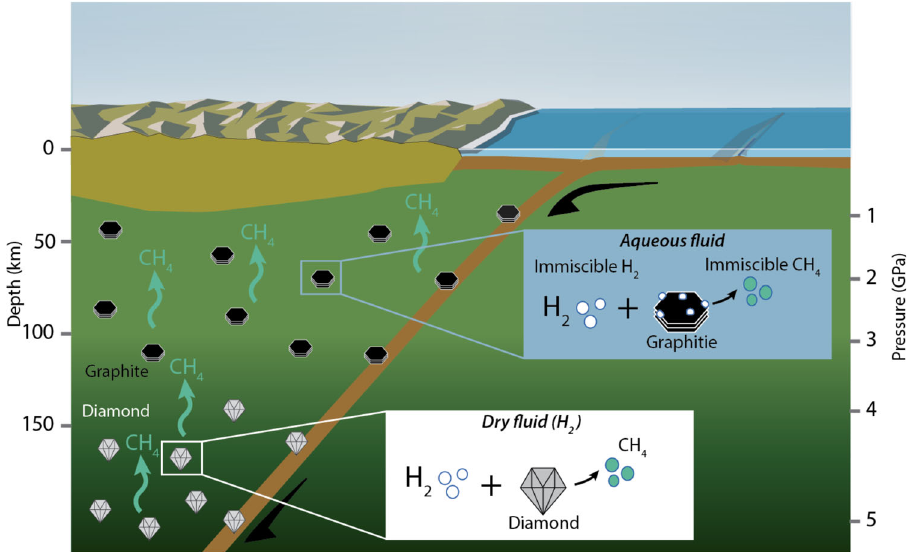
Fig. 1 Sketch modi fi ed after Fig. 1 in Li et al. 52 summarizing the implications of this study on the genesis of abiotic CH 4 in the upper mantle. Below about 140 km depth (4 GPa), the immiscibility of H 2 in aqueous fl uids 22 can promote interactions between H 2 gas and graphitic carbon, leading to the formation of CH 4 (Fig. 3). This condition is plausible in reducing settings with low oxygen concentrations within the upper mantle 17 or where reducing conditions are generated in subduction zones 25 . At greater depths in the diamond stability fi eld, the oxygen fugacity is predicted to be lower 14 and dry H 2 fl uids are more common 7, 8 and interact with diamond to form abiotic CH 4 (Fig.